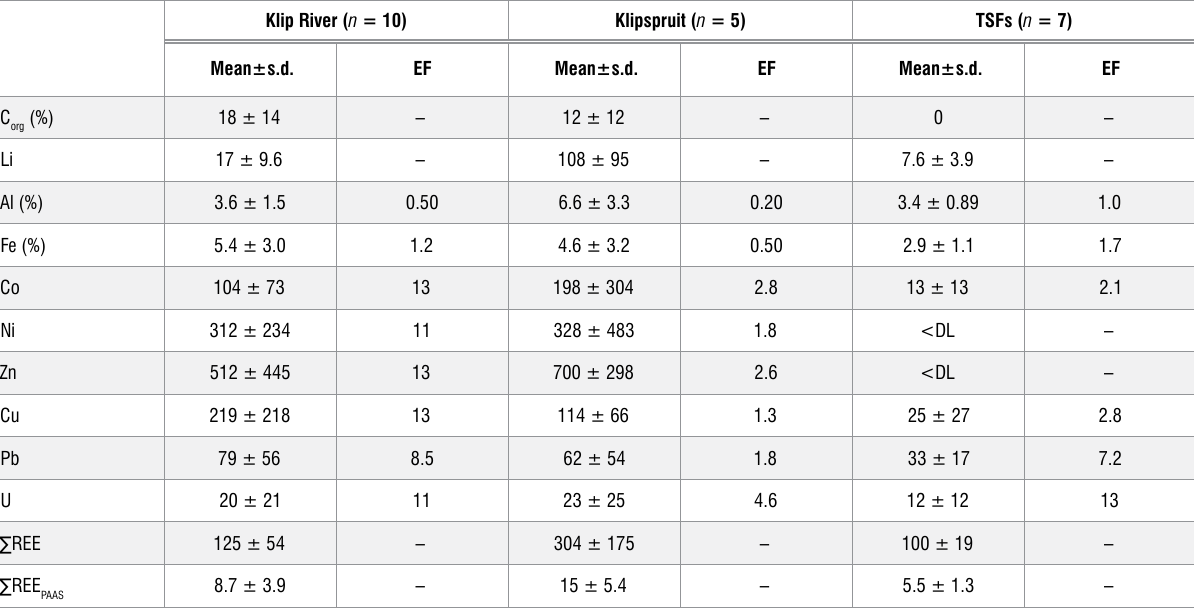
Mean concentrations (mg/kg) and enrichment factors (EF) for metals in tributary surface sediments and material from tailings storage facilities (TSFs) Klip River ( n =